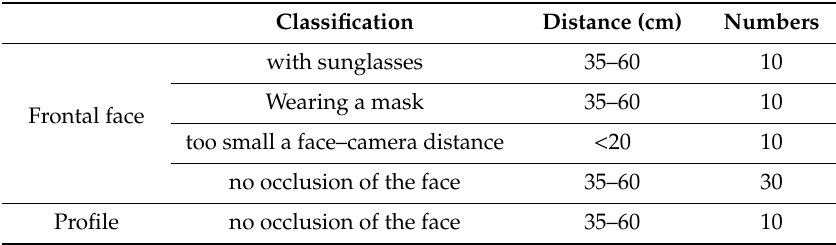
Table 6. Dataset